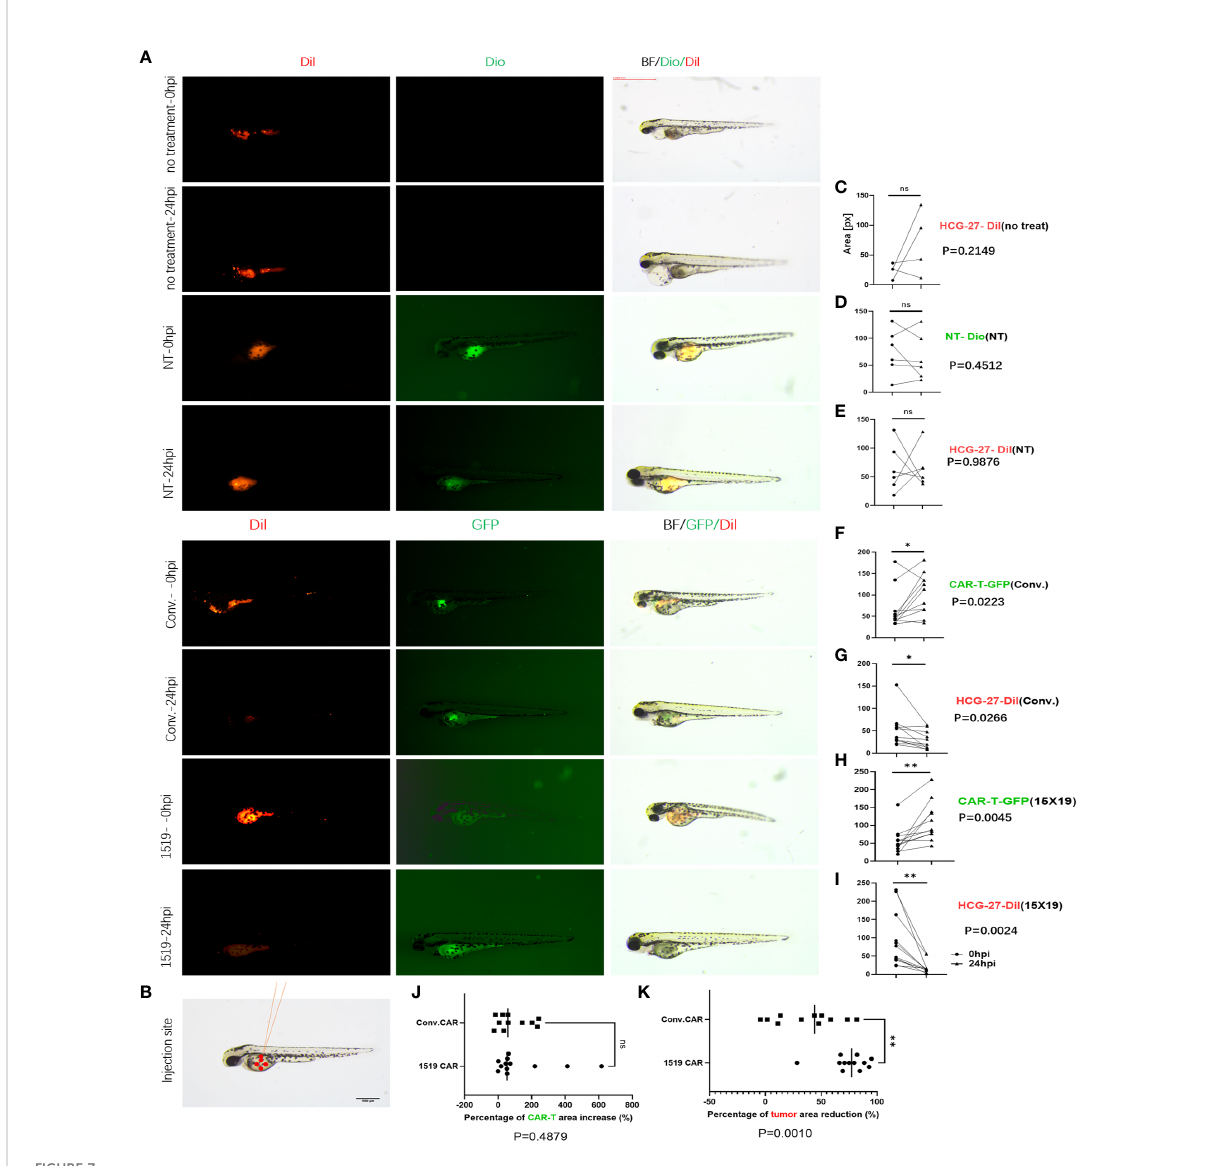
FIGURE 7 15×19 CAR T cells mediate cancer cells oncolysis in Zebra fi sh. (A) , Cell fl uorescence is visualized using fl uorescent stereomicroscopy 0 (0 hpi) and 24 (24 hpi) hour post-infection,; (B) , A diagrammatic sketch of tumor cells and effector cells injection into the vitellicle, scale bar = 1000 m M. (C) , No effector cells are injected in the untreated group, without green fl uorescence seen, while no reduction is seen in the area of fl uorescence in HCG- 27 cells (red fl uorescence); (D) , No apparent expansion of T cells (green fl uorescence) is seen in the NT group 24 hour post-infection; (E) , No reduction in the area of fl uorescence in HCG-27 cells 24 hours post-infection; (F) , Partial expansion of cells is seen in conventional CAR 24 hours post-infection; (G) , A reduction is observed in the area of fl uorescence in HCG-27 cells in conventional CAR group 24 hours post-infection; (H) , Apparent expansion of 15 × 19 CAR T cells is found in the 15 × 19 CAR group 24 hours post-infection; (I) , A signi fi cant reduction is observed in the area of fl uorescence in HCG-27 cells in the 15 × 19 CAR group24 hours post-infection. ( J ), There is no signi fi cant difference between the ampli fi cation of 15 × 19 CAR T cells and conventional CAR T cells; ( K ), A higher reduction is seen in the HCG-27 cells in the 15 × 19 CAR group. Analyzed for statistical signi fi cance by paired Student ’ s t test. ns, no signi fi cant difference; * P < 0.05; ** P <